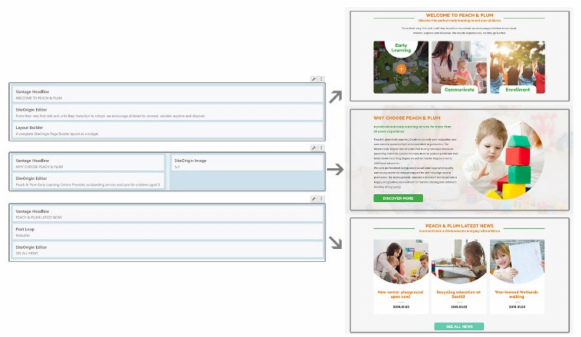
Figure 3. Page Builder System, back-end ( Left ) and front-end ( Right ).